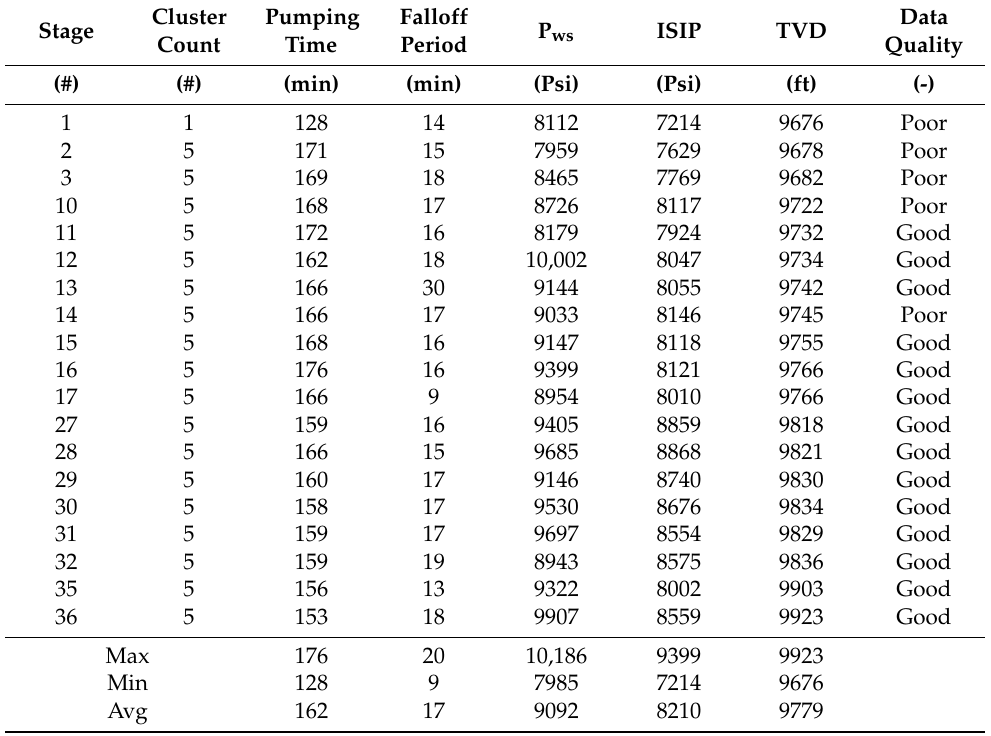
Table 11. Main hydraulic fracturing parameters and data quality check for post-treatment pressure analyses